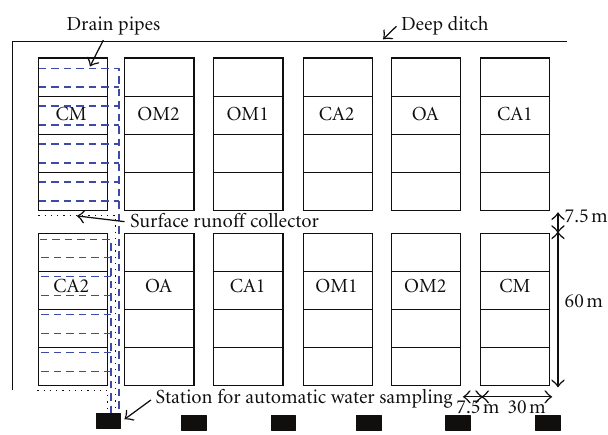
Figure 1: Layout of the cropping system experiment at